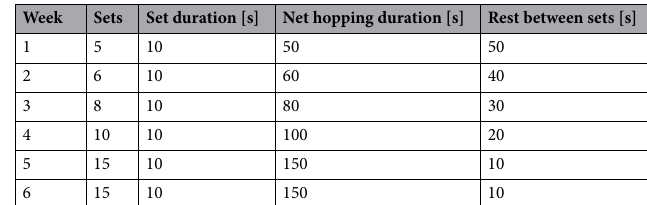
Table 1. Protocol of the hopping intervention. s